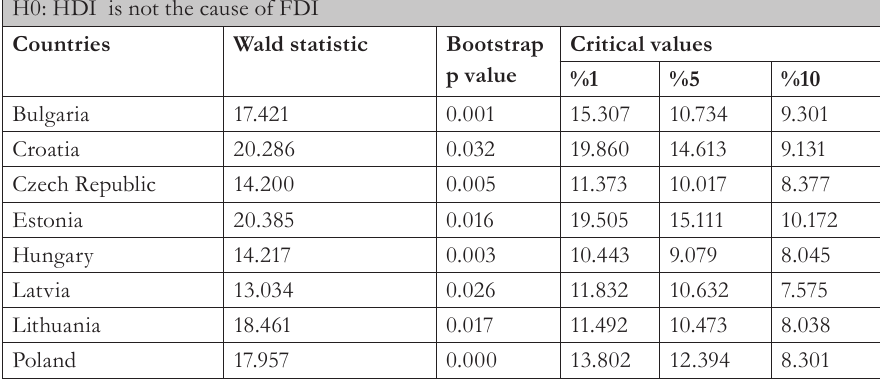
Tab. 9 – Results of causality test between FDI and HDI. Source: own